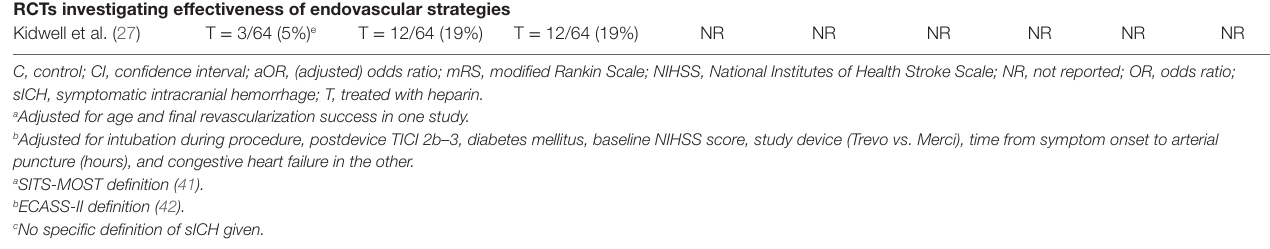
cohort studies and post hoc analyses Enomoto et al.